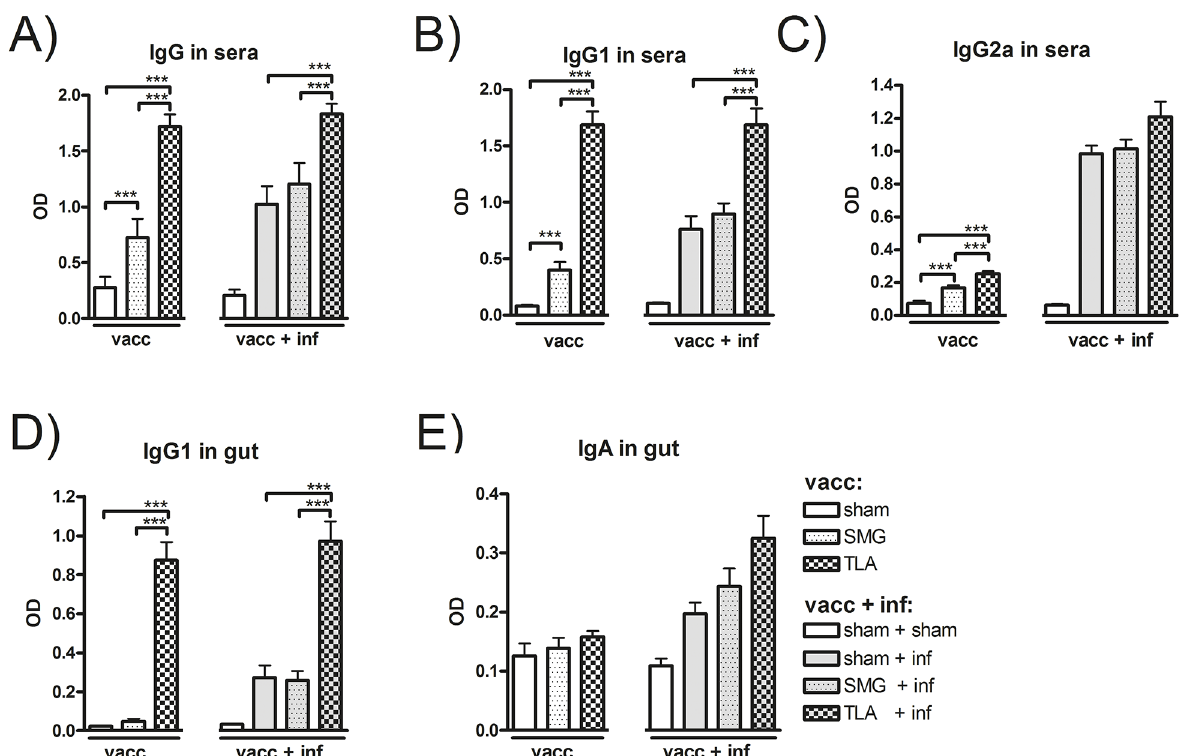
Fig 2. Toxoplasma -specific antibody levels in sera and gut. Toxoplasma -specific IgG (A), IgG1 (B) and IgG2a (C) antibody levels were measured in sera on day 34 (vacc) and day 83 (vacc + inf) by ELISA. Furthermore Toxoplasma -specific intestinal IgG1 (D) and IgA (E) levels were measured by ELISA in lavage fluids from the small intestines obtained at day 34 (vacc) and day 83 (vacc + inf). Results represent data of two independent experiments. Data are expressed as mean ± SEM. *** p <